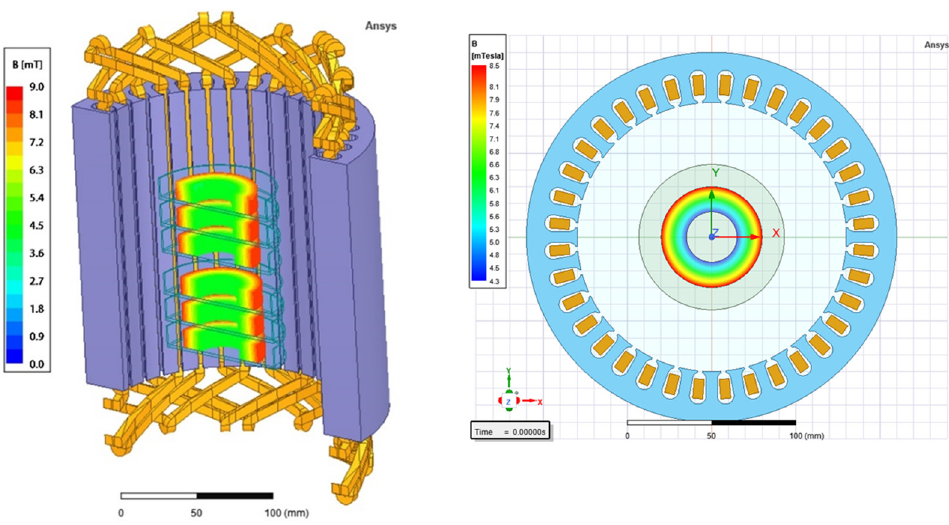
Figure 5. Arrangement and location of the Petri dishes in RMF reactor chamber. The place from which the bacteria were harvested for further tests and analyzes has been marked as a colored circle; different colors show the distribution of the magnetic induction depending on its value.